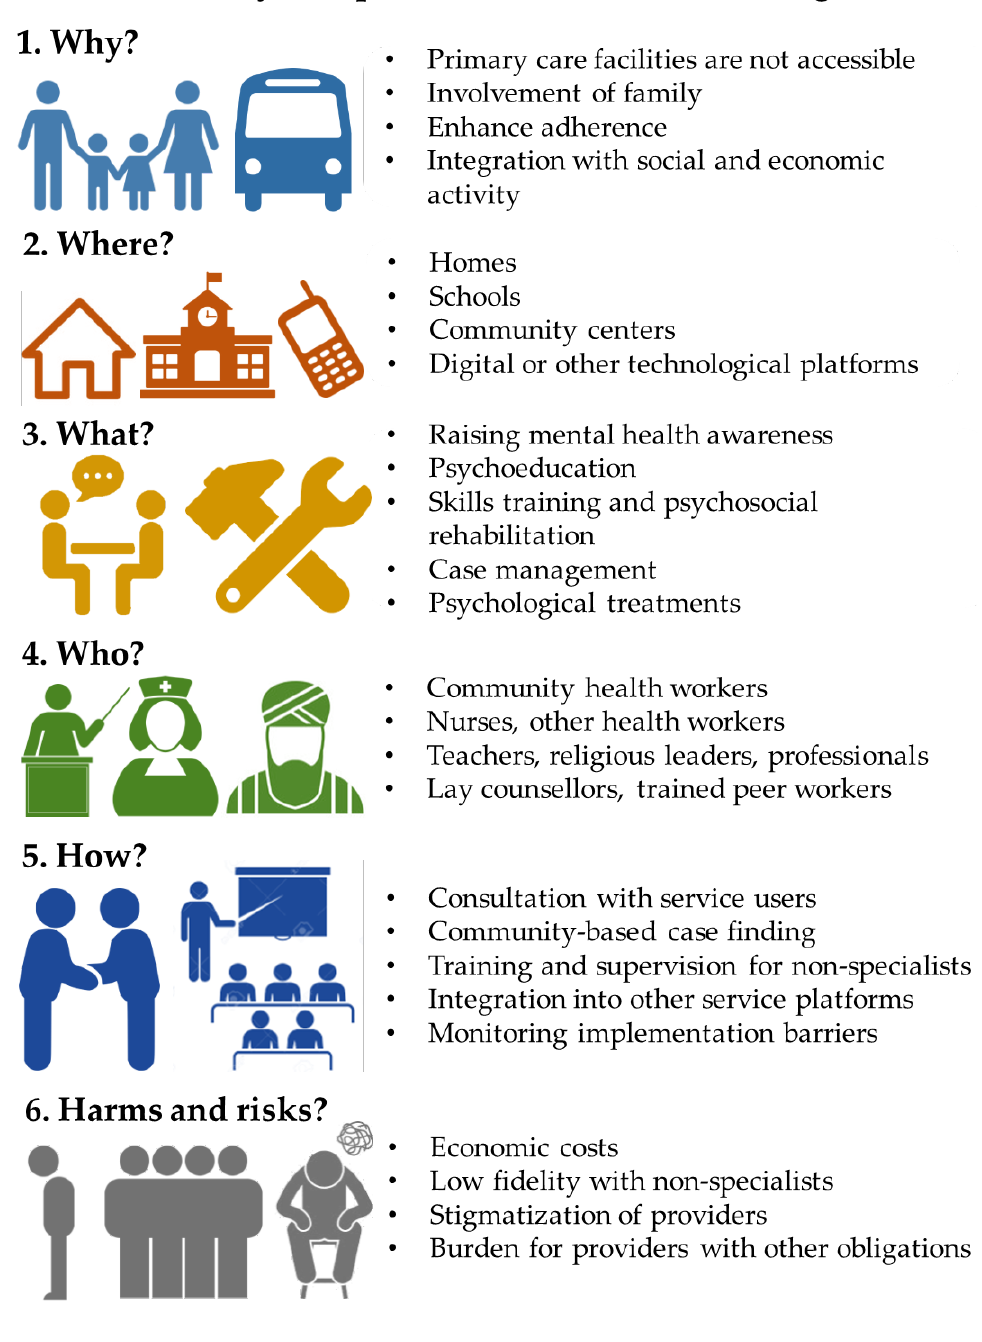
Figure 2. Domains for community mental health platforms.